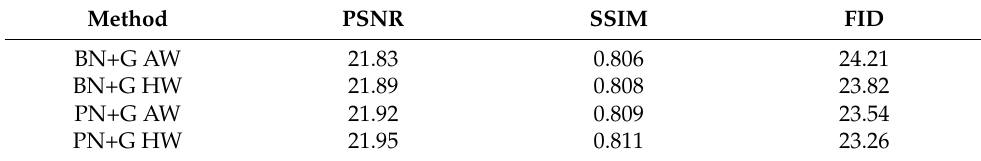
Table 2. Quantitative ablation study on the Places2 dataset.